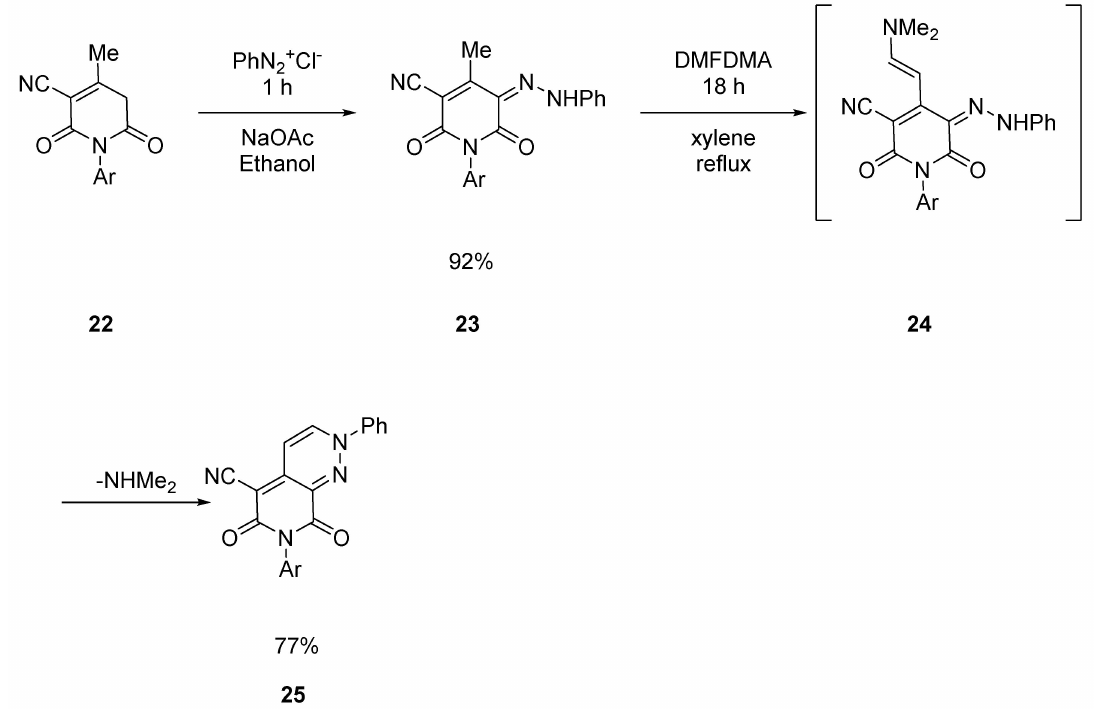
The N-unsubstituted pyridinedione derivatives 26 were condensed with arylidene- malononitrile in the presence of piperidine base in ethanol solvent at reflux. After the Michael addition of the deprotonated methyl to the electron poor alkene, malononitrile is eliminated by intramolecular substitution. The intermediate 3,4-dihydro compounds 27 are aromatized in situ to the final products 28 (6 examples, 70–75% yield) by ambient oxygen (Scheme 6) [23,24]. A similar entry to analogs of 28 (6-C(CN)2 instead of 6-oxo) by Knoeve- nagel condensation of 4-methyl-6-dicyanomethylpyridones with aromatic aldehydes was reported